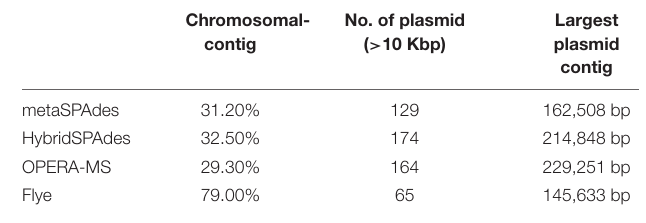
TABLE 4 | Summary of chromosomal and plasmids